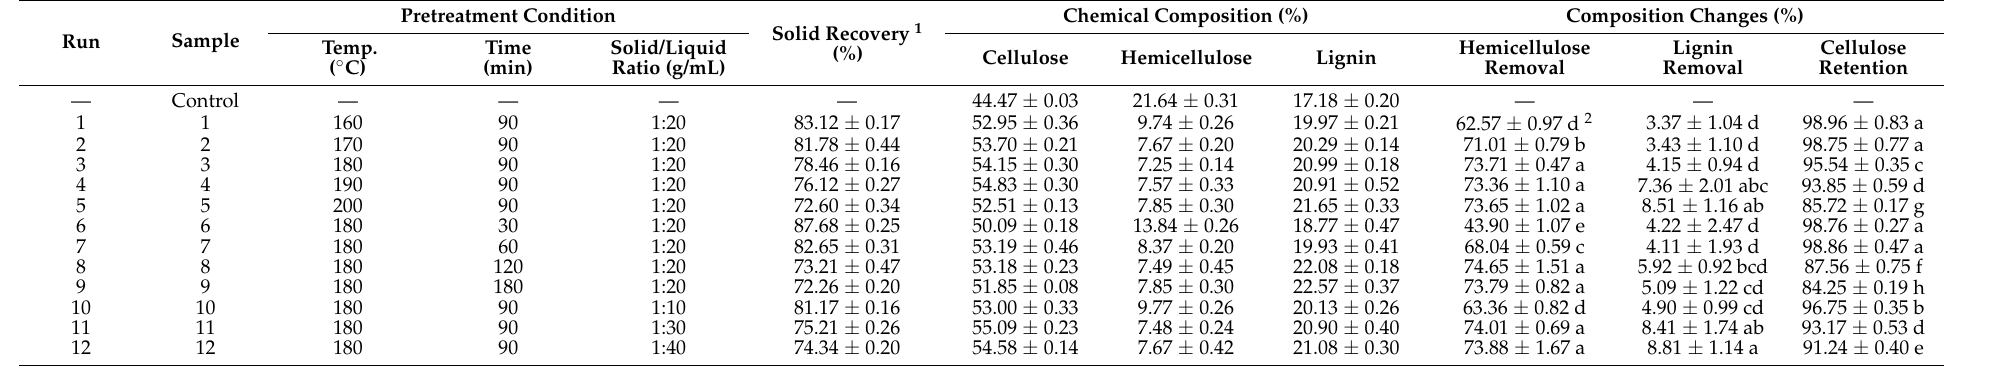
Table 2. Changes in chemical components of rice straw samples before and after the LHW